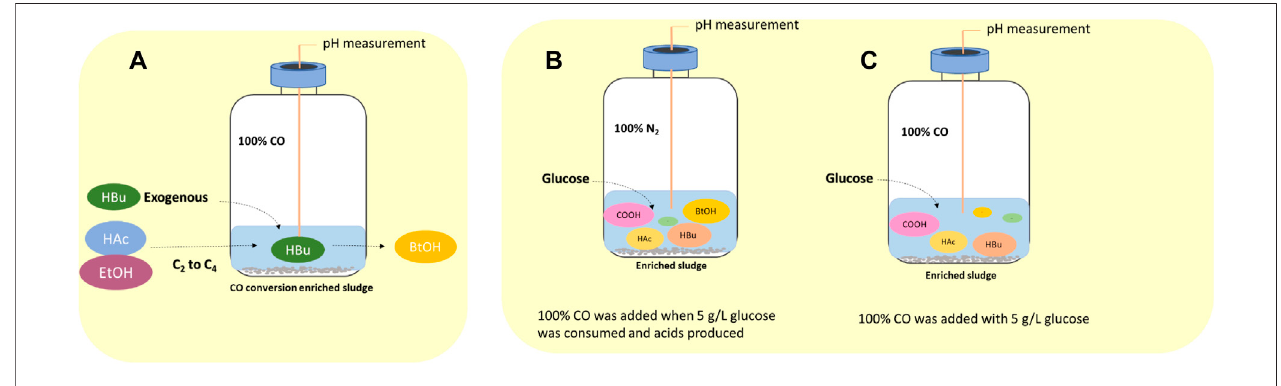
FIGURE 1 | Schematic diagram of (A) in fl uence of exogenous acetate, butyrate and ethanol on butanol production using CO as gaseous substrate, (B) endogenous butyric acid from glucose (Glucose + N 2 ) and (C) co-fermentation of CO and glucose (Glucose +